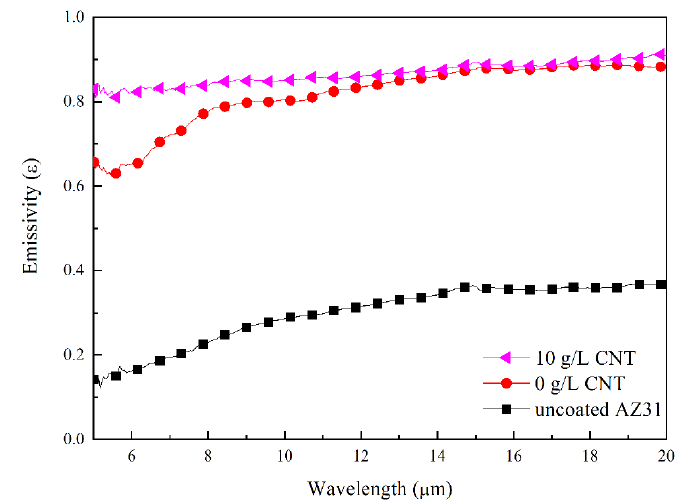
Figure 12. Emissivity of PEO coatings with and without CNT and the AZ31 Mg substrate measured at 100 °C , via Fourier transform infrared spectroscopy (FT-IR). Figure 13 shows the heat-transfer mechanism of the PEO coating with and without CNT additive. The thermal conductivity of MgO acting as an thermal insulator in the coating layer was quite low, at about 30 W ⋅ m −1 ⋅ k −1 [44]. However, the composite PEO coating could improve thermal conductivity by incorporating a CNT additive with high thermal conductivity (2000–6000 W ⋅ m −1 · k −1 ) into the oxide layer [45]. In addition, the PEO coating with a CNT additive has a thin and dense structure. When the thickness of the coating was thin, the distance of the heat-conduction path having low thermal conductivity was shortened. The size of the pore band also decreased, and the area of the heat-obstructing vacancies was reduced, thereby exhibiting improvement in heat-conductive ability. When the heat is transferred to the coating surface, a high emissivity oxide coating with a CNT additive caused a large amount of thermal radiation, which improved the heat-dissipation capability of the PEO coating.